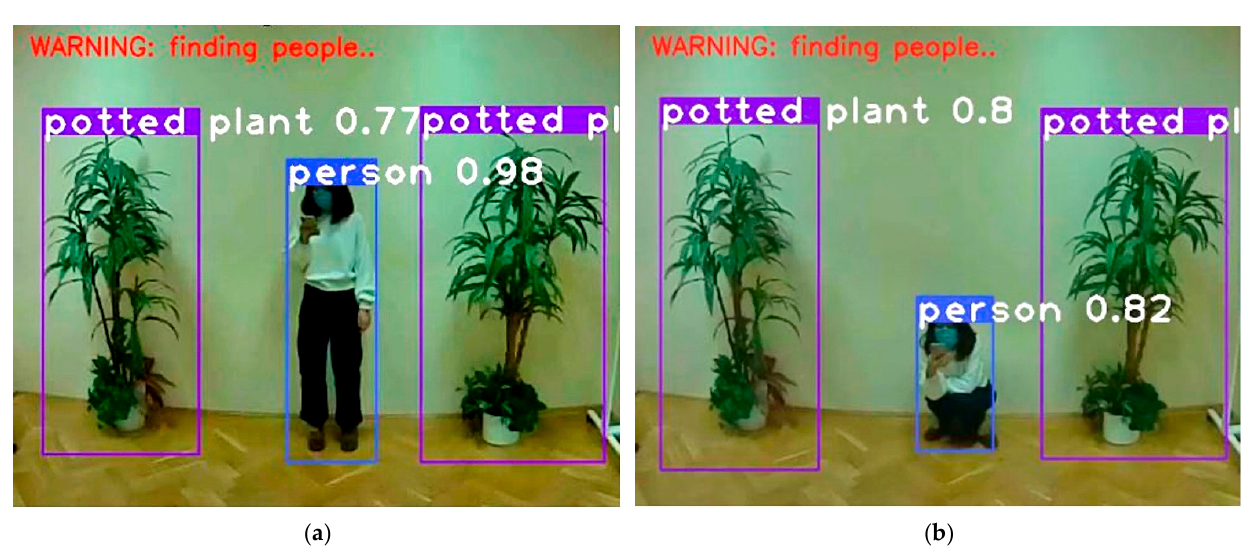
Figure 7. Human detection standing ( a ) and squatting ( b ) by using yolo3-tiny.